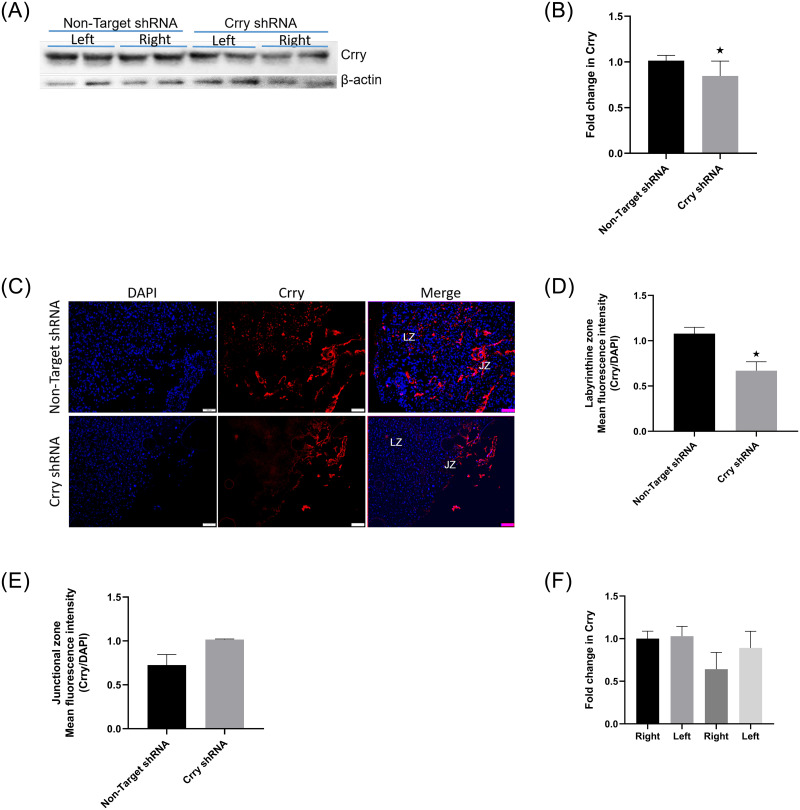
Downregulation of placental Crry.Lentiviral vectors enclosing Crry or non-target shRNA were injected into right uterine horn of pregnant mice (n = 5–7) on 3.5 dpc, shRNA was induced on 10.5 dpc and placental expression of Crry on 17.5 dpc was analyzed. A) Representative Western blot showing downregulation of Crry in CrryshRNA mice. In each group placentas from both left and right uterine horn were used in the blot. B) Density analysis of Crry Western bands showing about 30% reduction in Crry levels in CrryshRNA mice compared to control mice (p<0.021). C) Representative immunofluorescence images showing reduced Crry expression in CrryshRNA mice. D) Semi quantitation of fluorescence intensity revealed significant downregulation (p = 0.04) of Crry in the labyrinthine zone of CrryshRNA mice compared to control mice. E) There was no change in fluorescence intensity in junctional zone between the two groups. F) In CrryshRNA mice downregulation of Crry on placentas from right uterine horn showed trend of increase compared to those from left uterine horn.